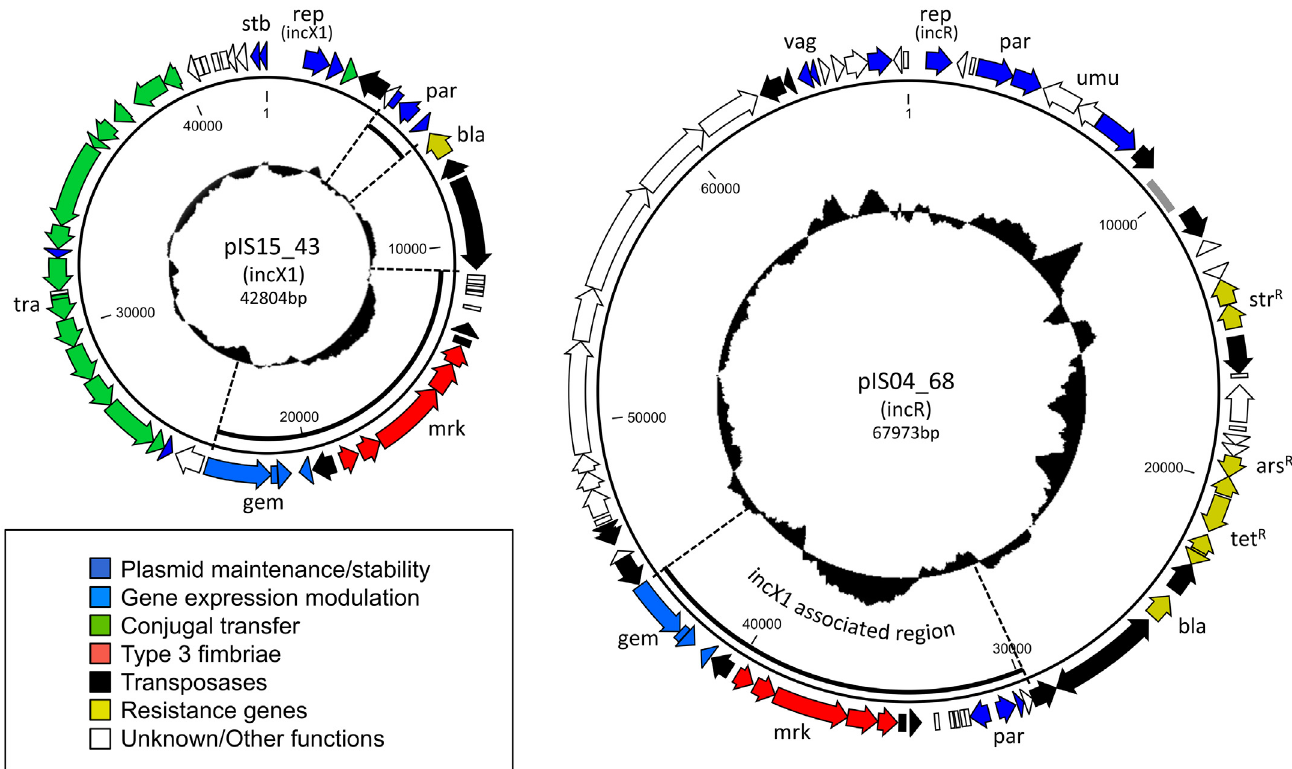
Fig 1. Graphic representation of annotated plasmids pIS15_43 and pIS04_68. %GC content is illustrated in the center of the plasmid diagrams. Regions of pIS04_68 (IncR) that are typically associated with the IncX1-type plasmids (such as pIS15_43) have been highlighted in both sequence